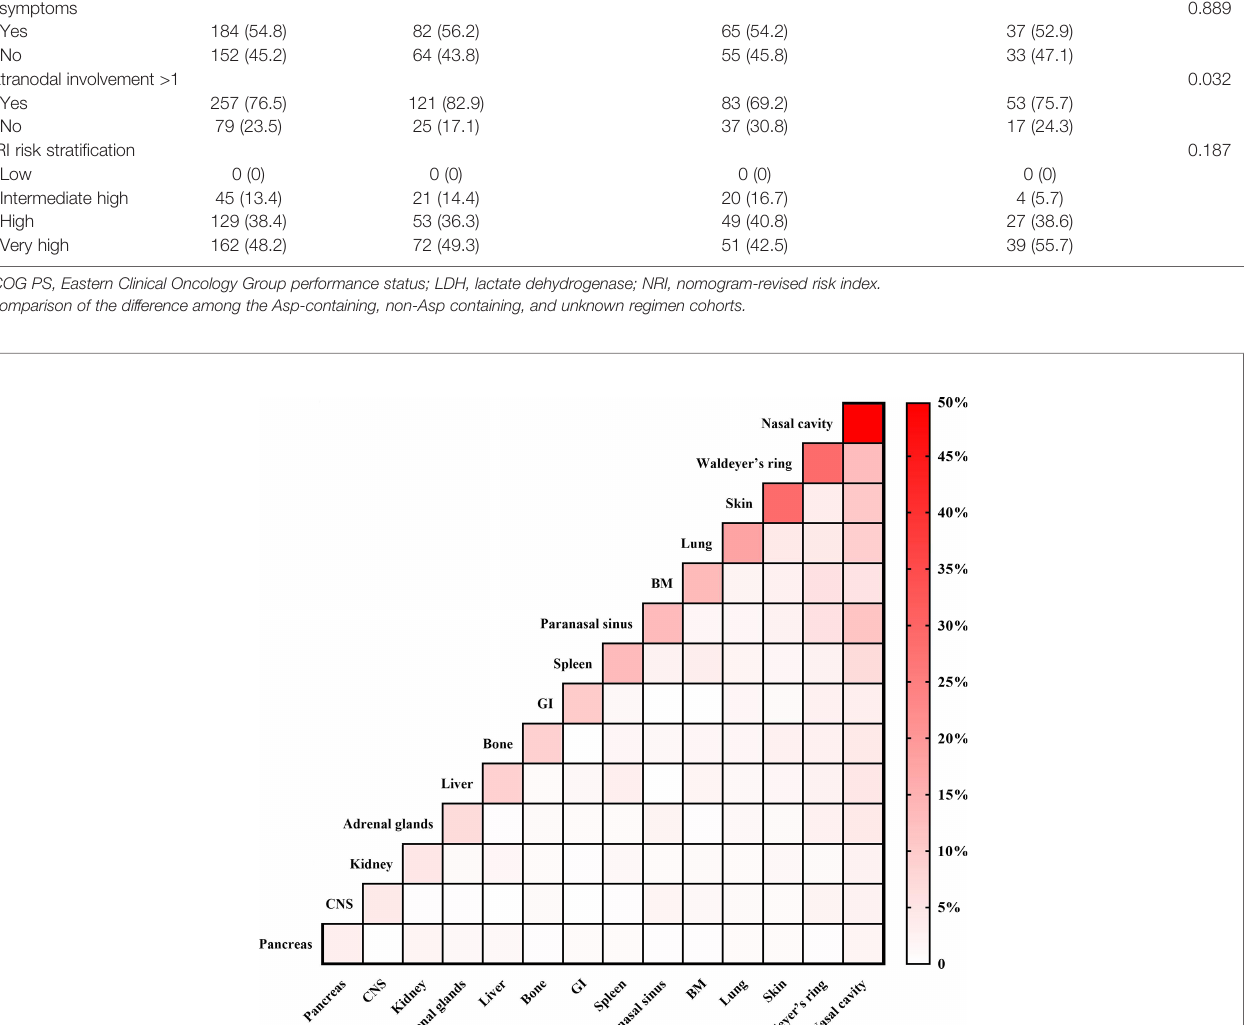
Frontiers in Oncology |